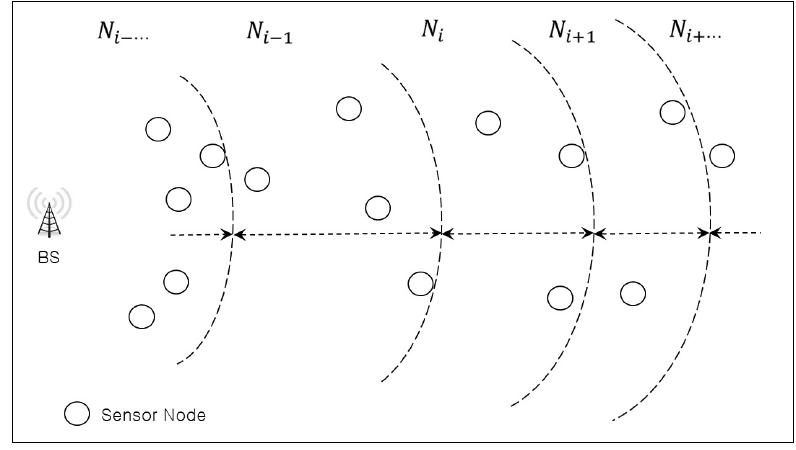
Figure 8. Layer configuration of